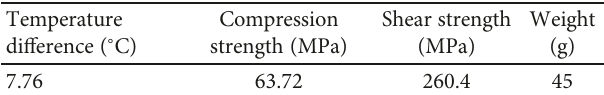
Figure 7: Performance analysis of honeycomb aluminum plate: (a) temperature di ff erence, (b) compression strength, and (c) shear strength. Table 4: Performance analysis results of the honeycomb aluminum